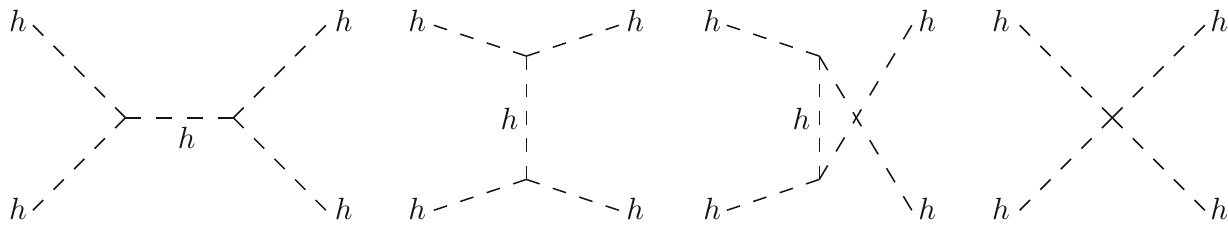
Fig. 2 hh → hh scattering amplitudes: s + t + u channels + 4-vertex (4vrtx) contributions